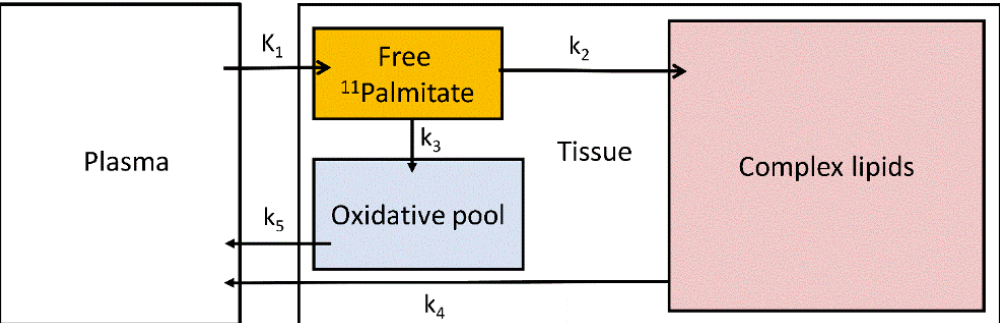
Figure 4. Three-tissue compartmental model of 11 C-palmitate kinetics. K 1 and k 2–5 are the transfer rate constants between plasma, tissue free 11 C-palmitate pool, oxidative pool and complex lipids. 18 F-FTHA differs from real fatty acids due to the sulfur heteroatom substituting the sixth carbon in the fatty acid carbon chain [97]. The presence of sulfur atom causes the metabolism of 18 F-FTHA to stop after two cycles of beta oxidation, and 18 F-labels from the metabolites of this process are trapped in the tissue [97]. 18 F-FTHA is bound to phospho- lipids and glycerol esters [97,98], albeit fractional esterification into triglycerides has been shown to be impaired compared to 14 C-palmitate [99] and in response to insulin [98,99]. The property of efficient trapping in the tissue allows the use of the Patlak graphical model to measure tissue uptake between 10 and 32 min from tracer injection before tracer loss from the tissue starts to bend the curves at later time points